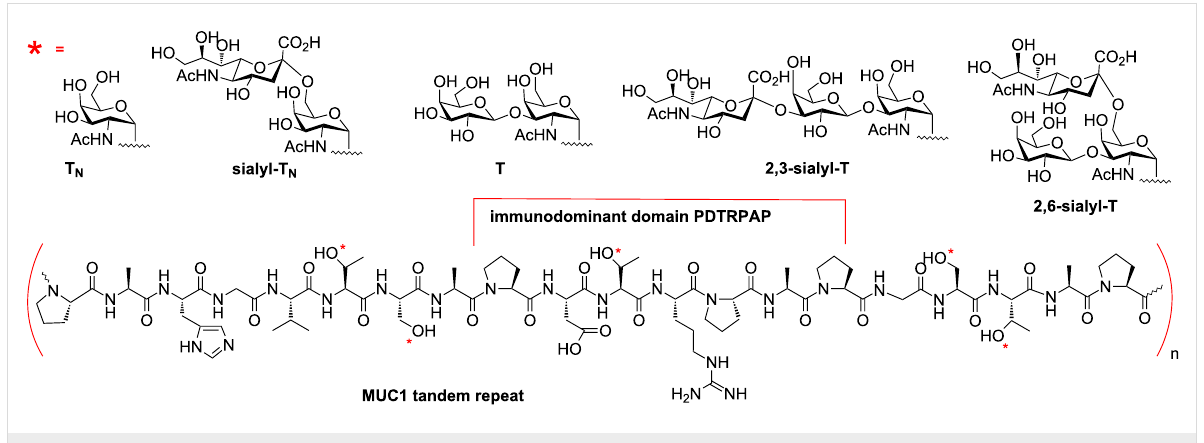
Figure 1: Tumor-associated glycosylation on MUC1 tandem repeat